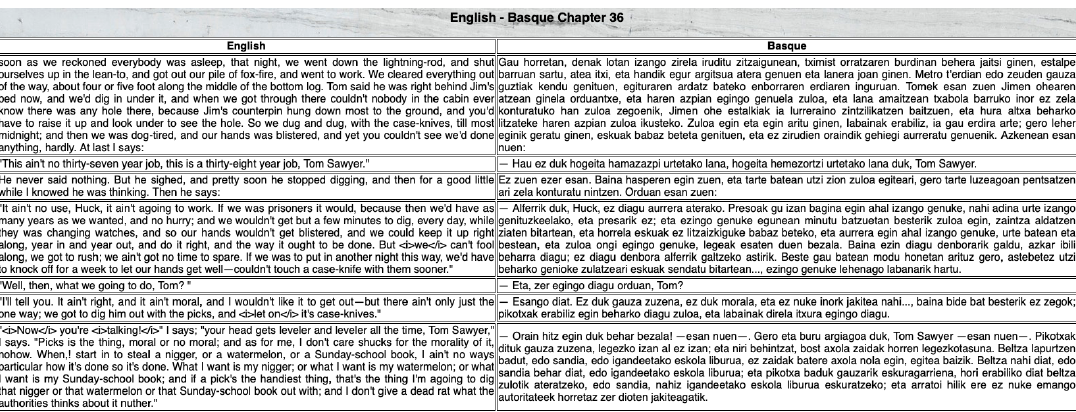
Figure 7. Paragraph alignment of Chapter 36 between the original English ( left ) and Basque translation ( right ) of the novel “Adventures of Huckleberry